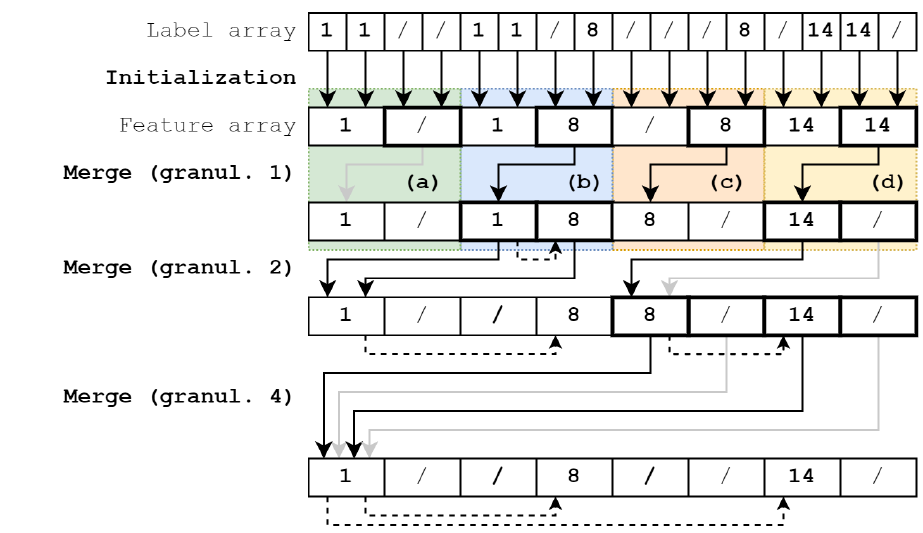
Figure 2. Iterative merging of initially disjoint trees on GPU. Boldly outlined boxes represent source nodes for each step (each assigned a separate thread). Note that threads for invalid source nodes return early (indicated by gray arrows). Dashed arrows indicate parent-child relationships between nodes. Scenarios (a) through (d) are described in Section 3.2.2.